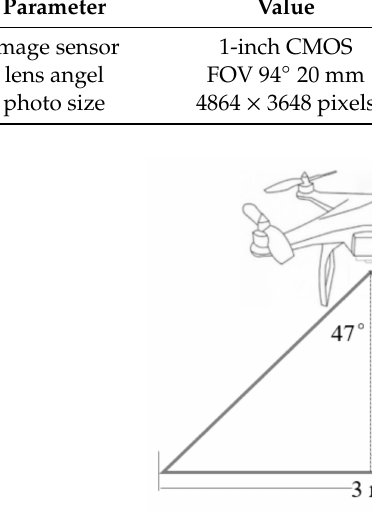
Figure 2. Schematic diagram of the flight